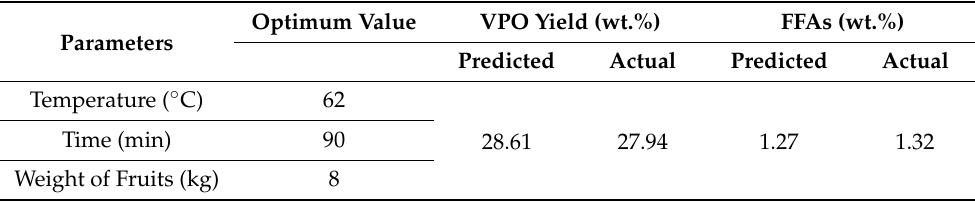
Table 5. Optimized experimental conditions of oil palm fruit sterilization for maximum cold-pressed VPO production with minimal FFA